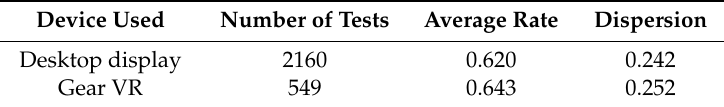
Table A8. Numerical results of the users regarding the device used.